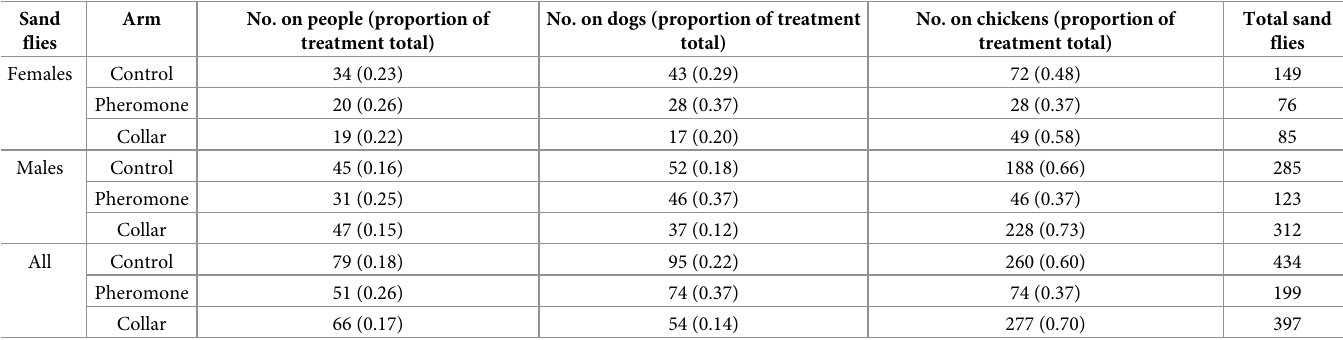
Table 6. Distribution of household Lu . longipalpis captured in CDC light traps 1 located in associated with important blood-source hosts. Sand